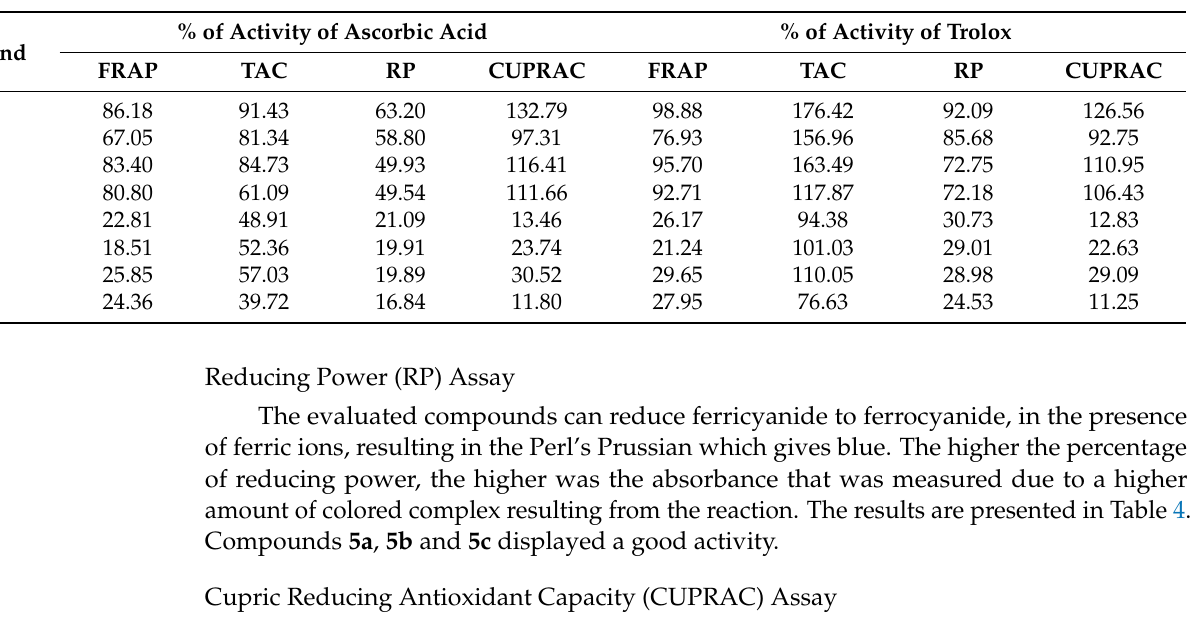
Table 4. Results of the Ferric Reducing Antioxidant Potential (FRAP), Total Antioxidant Capacity (TAC), Reducing Power (RP) and Cupric Reducing Power (CUPRAC) assays, expressed as % activity of ascorbic acid and Trolox.